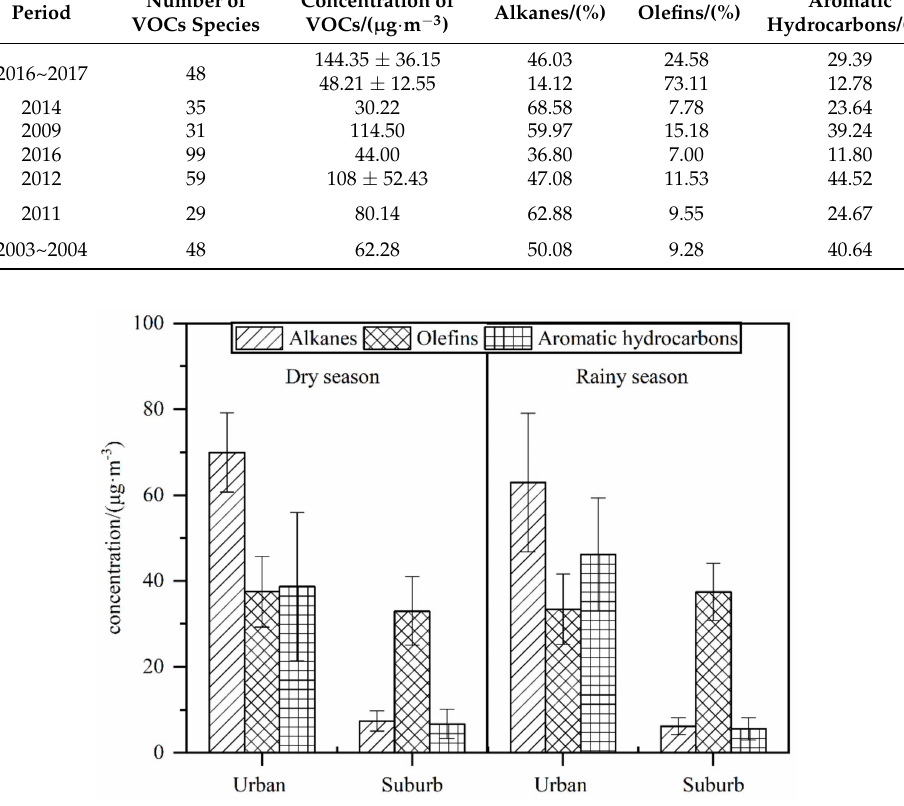
Figure 2. Concentration of alkanes, olefins, and aromatics in urban and suburban areas of